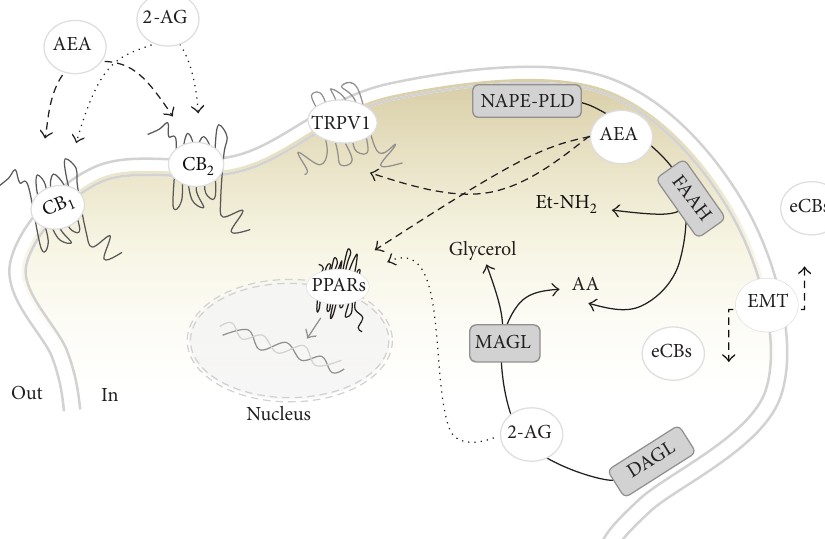
Figure 1: Schematic representation of the ECS. N -arachidonoyl-ethanolamine (AEA) is mainly produced by the activity of an N - acylphosphatidylethanolamine-specific phospholipase D (NAPE-PLD), whereas its degradation is due to a fatty acid amide hydrolase (FAAH), which releases ethanolamine (Et-NH 2 ) and arachidonic acid (AA). 2-Arachidonoylglycerol (2-AG) is also released from membrane lipids through the activity of diacylglycerol lipase (DAGL) and can be hydrolyzed by a cytosolic monoacylglycerol lipase (MAGL) that releases glycerol and AA. The cellular uptake from the extracellular to the intracellular space is ascribed to a purported “endocannabinoid membrane transporter (EMT)” that is likely to take up both AEA and 2-AG. Both eCBs trigger several signal transduction pathways by acting at their targets, CB 1 , CB 2 , GPR55, and nuclear peroxisome proliferator-activated receptors (PPARs). AEA, but not 2-AG, binds intracellularly also Transient Receptor Potential Cation Channel type 1